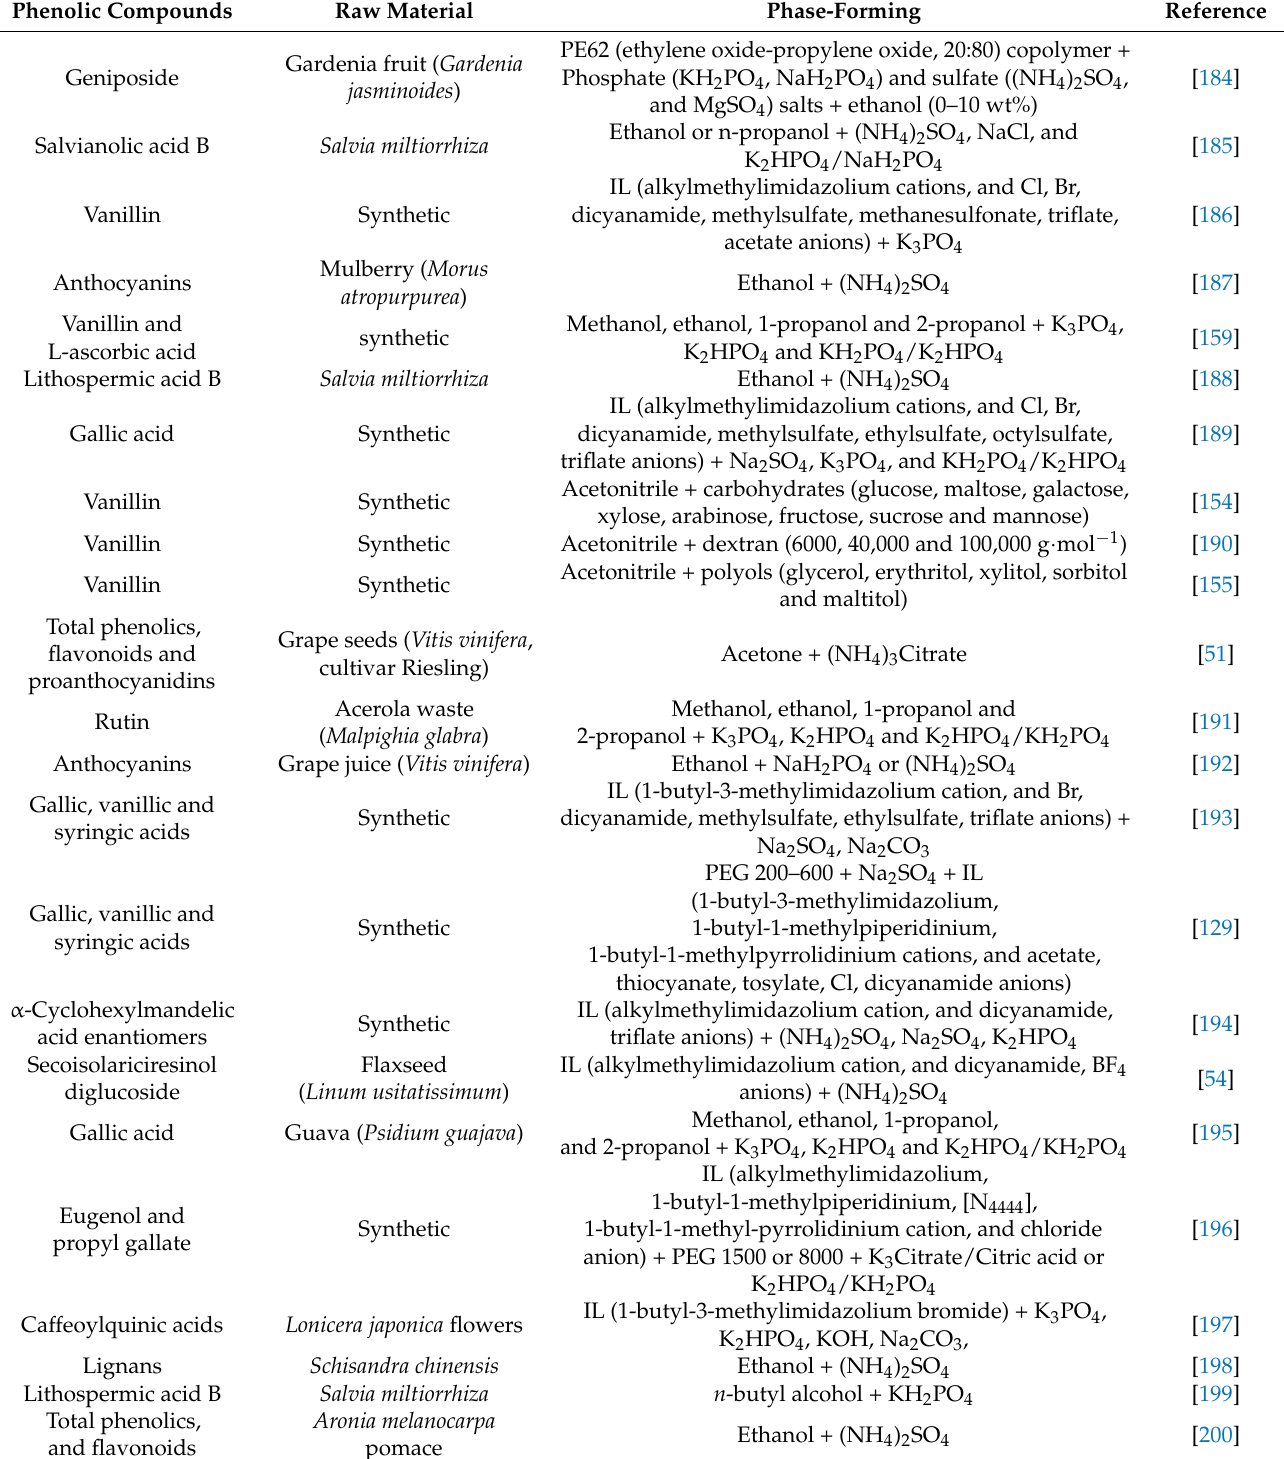
Table 1. Nonconventional ATPS in the extraction and recovery of phenolic